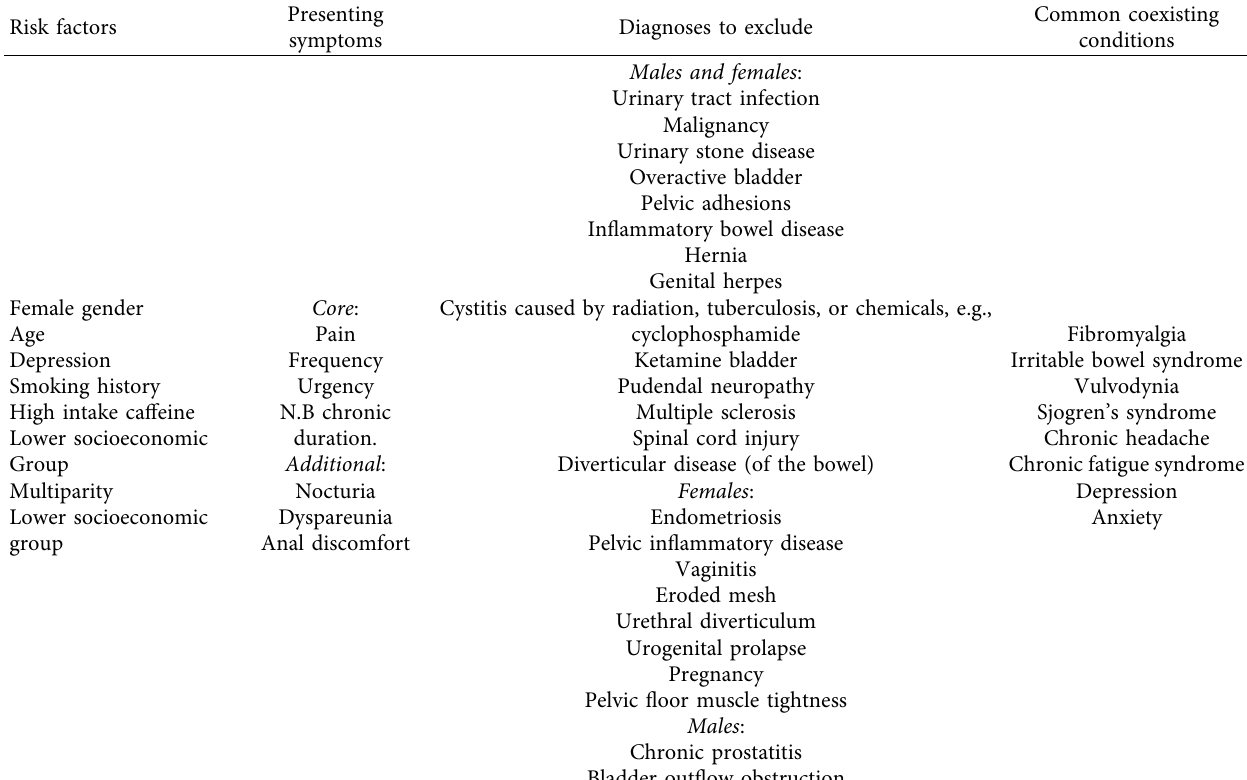
Table 1: Characteristics of